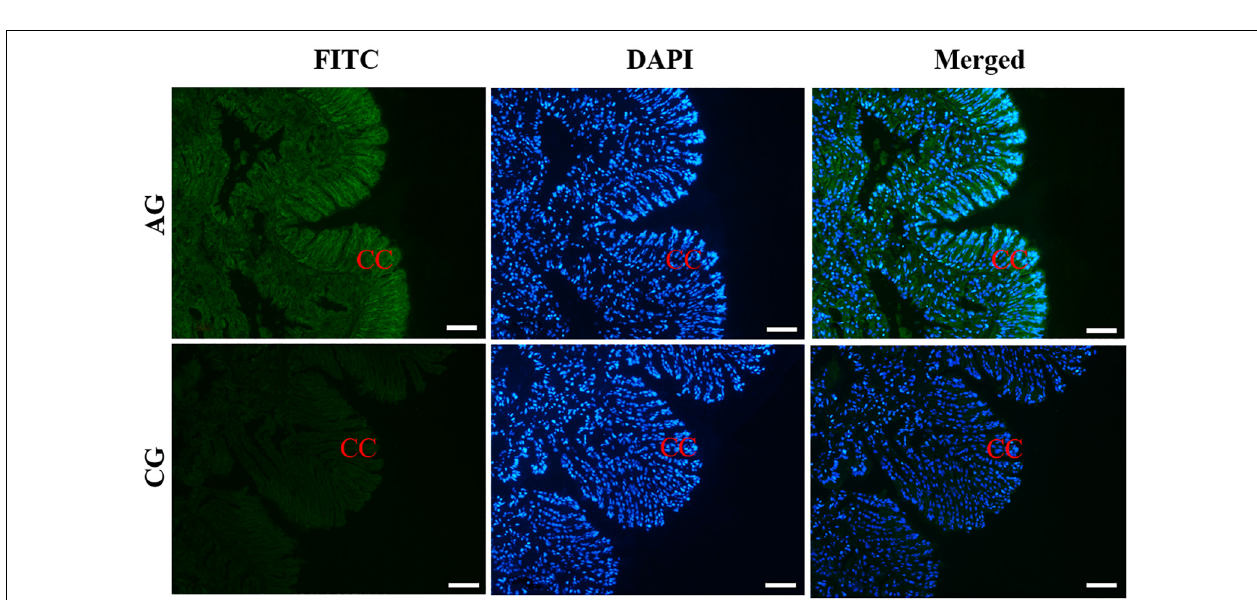
FIGURE 3 | Immunofluorescence of Sc-GDH in the gills of S. constricta . Sc-GDH protein was stained with the anti-GDH antibody in green, and nuclei were stained with DAPI in blue. The merged images were co-localized with Sc-GDH protein (green) and DAPI (blue) in the columnar cells of lateral cilia of gills. CC, columnar cells. Scale bars were 50 µ m.